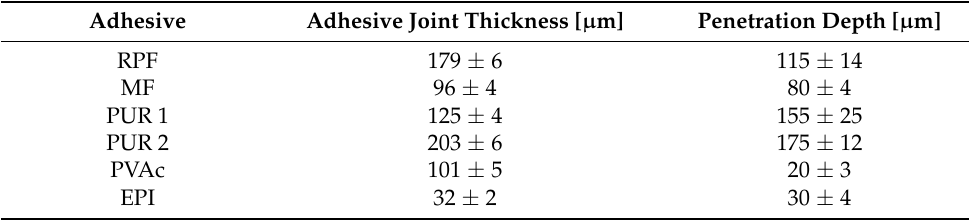
Figure 3. 3D illustration of the voids in the adhesive joints. Table 5. Penetration depths and adhesive joint thicknesses of the bonded test